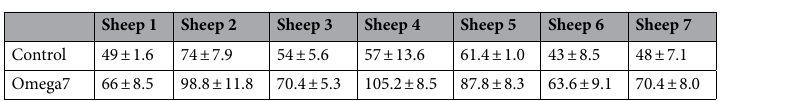
Table 2. Number of blood vessels in grafted wounds at 14 days. Data are shown as mean ±